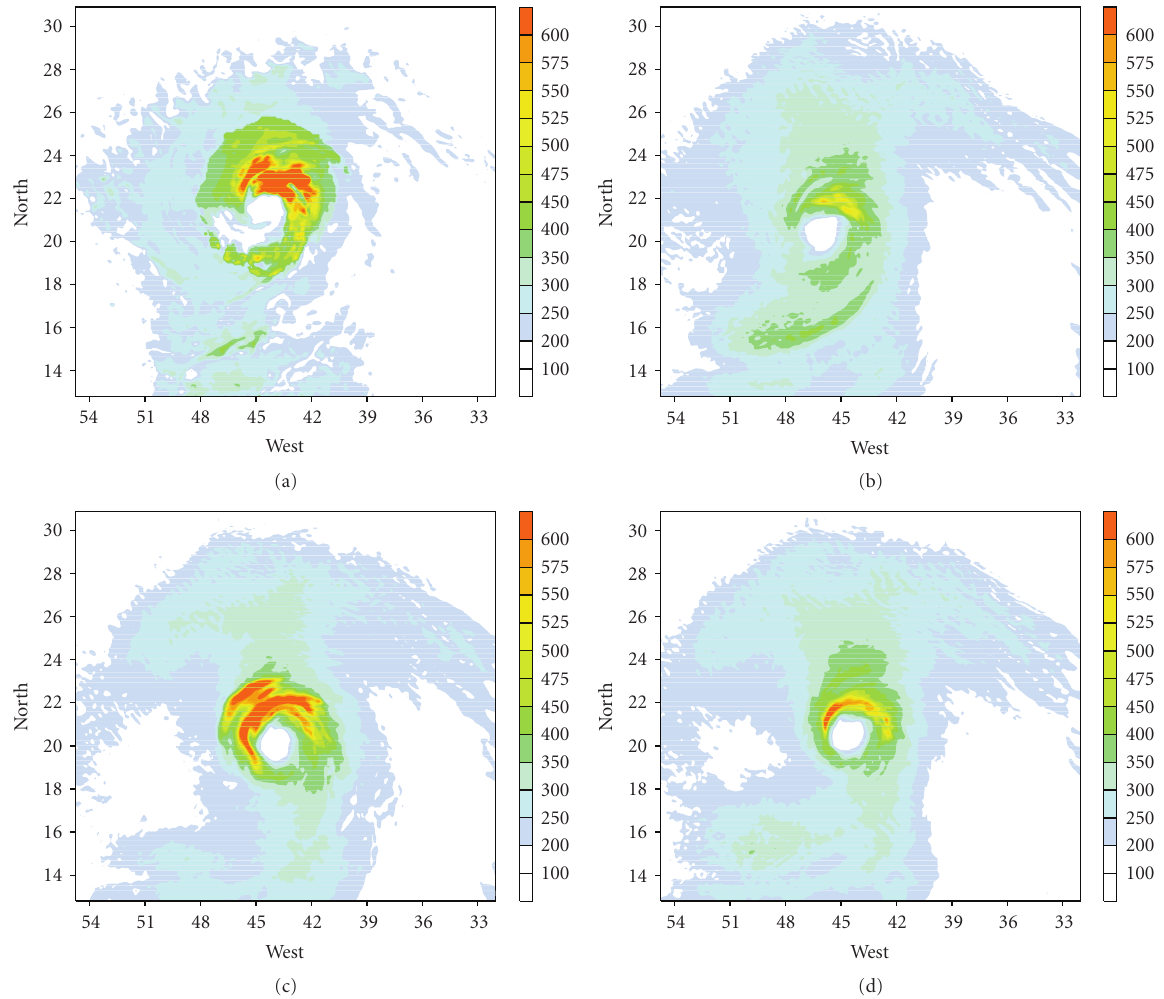
Figure 9: The surface latent heat flux (Wm − 1 ) from (a) regional nature run, (b) control run, (c) data assimilation Experiment 1, and (d) data assimilation Experiment 2 at 1800 UTC 02 October